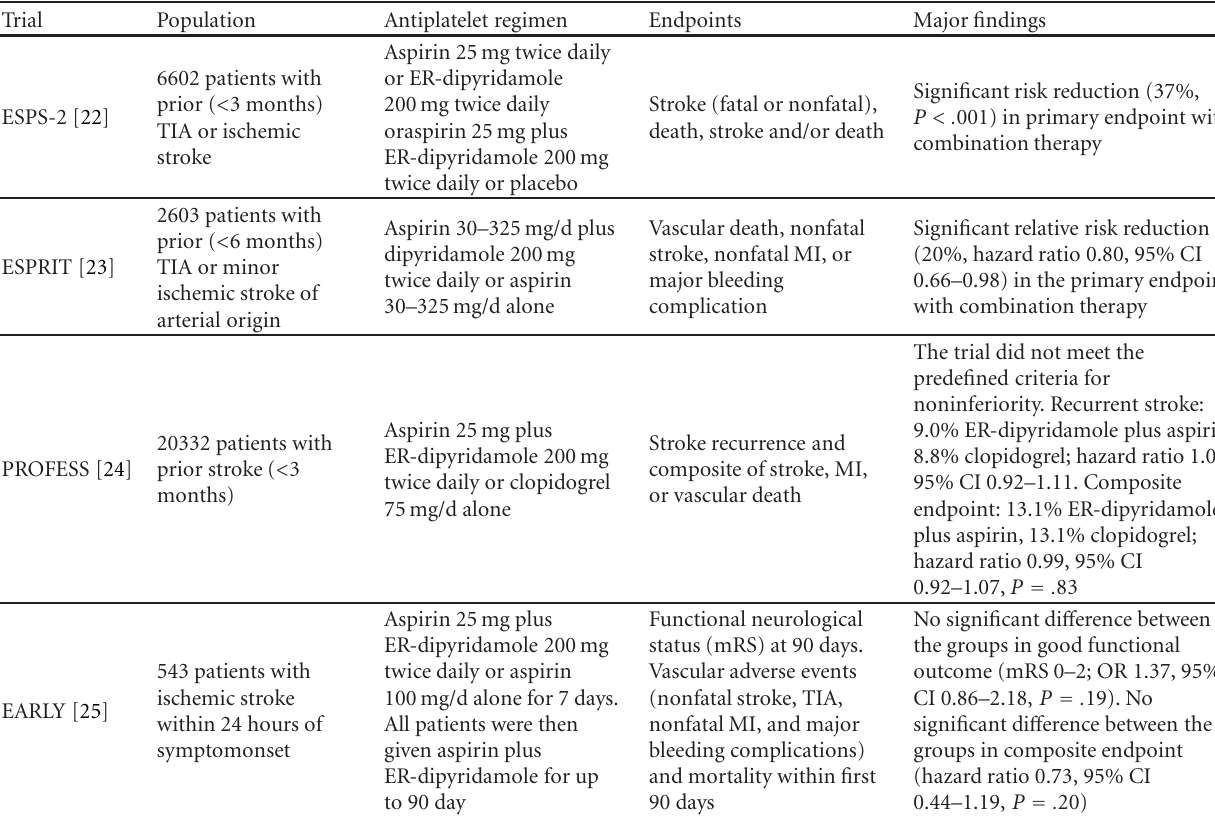
Table 1: Randomized clinical trials on aspirin plus dipyridamole after stroke or